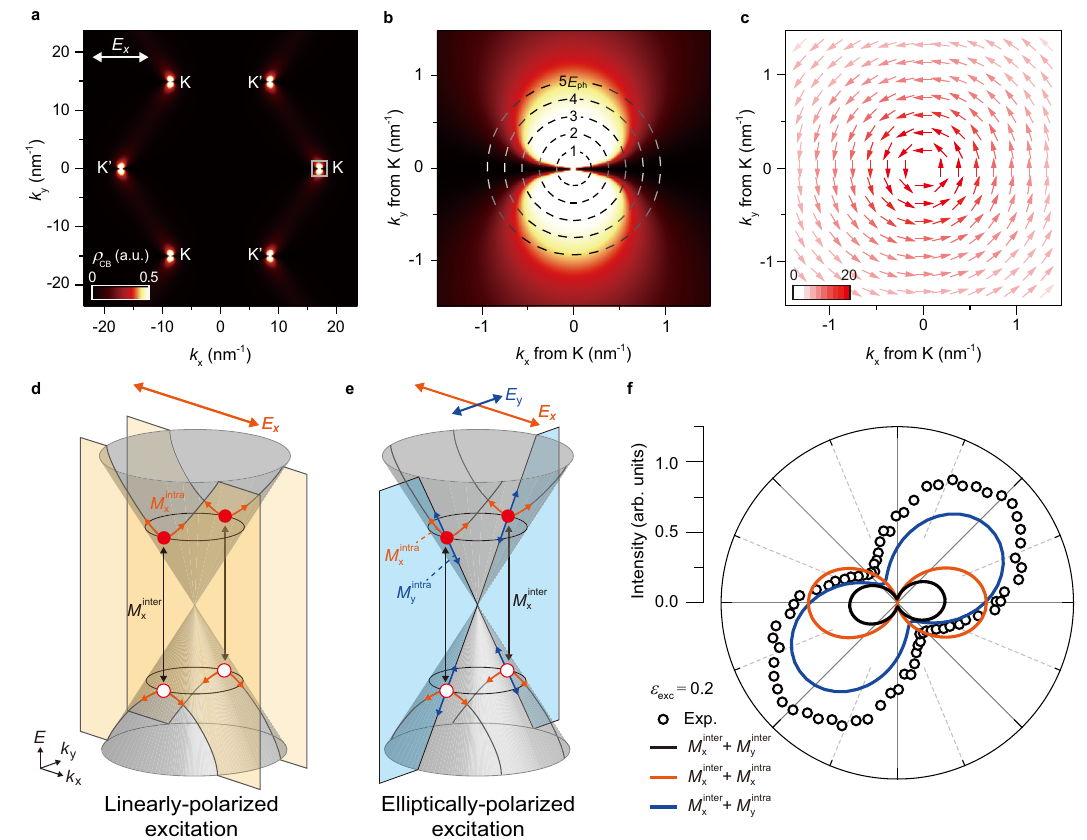
Fig. 4 | Theoretical calculation of HHG from massless Dirac fermions in graphene. a Photo-excited charge carrier population in the conduction band ρ CB under linearly-polarized laser fi eld along the x-direction ( E x ). b Detailed pro fi le of carrierpopulationaroundKpoint(regionmarkedwithawhitesquarein a ).Dashed lines are constant energy contours on a Dirac cone, which describes conduction band states vertically separated by energy mE ph . c Transition dipole moment pro fi le. Color scale and arrow show the magnitude and direction of transition dipolemoment. d , e Microscopicchannelsforcarrierdynamicsatthestatesonthe k y -axis. Under linearly-polarized excitation alongthex-direction ( d ),the interband transition (black arrows labeled with M inter x ) creates and recombine photo-excited